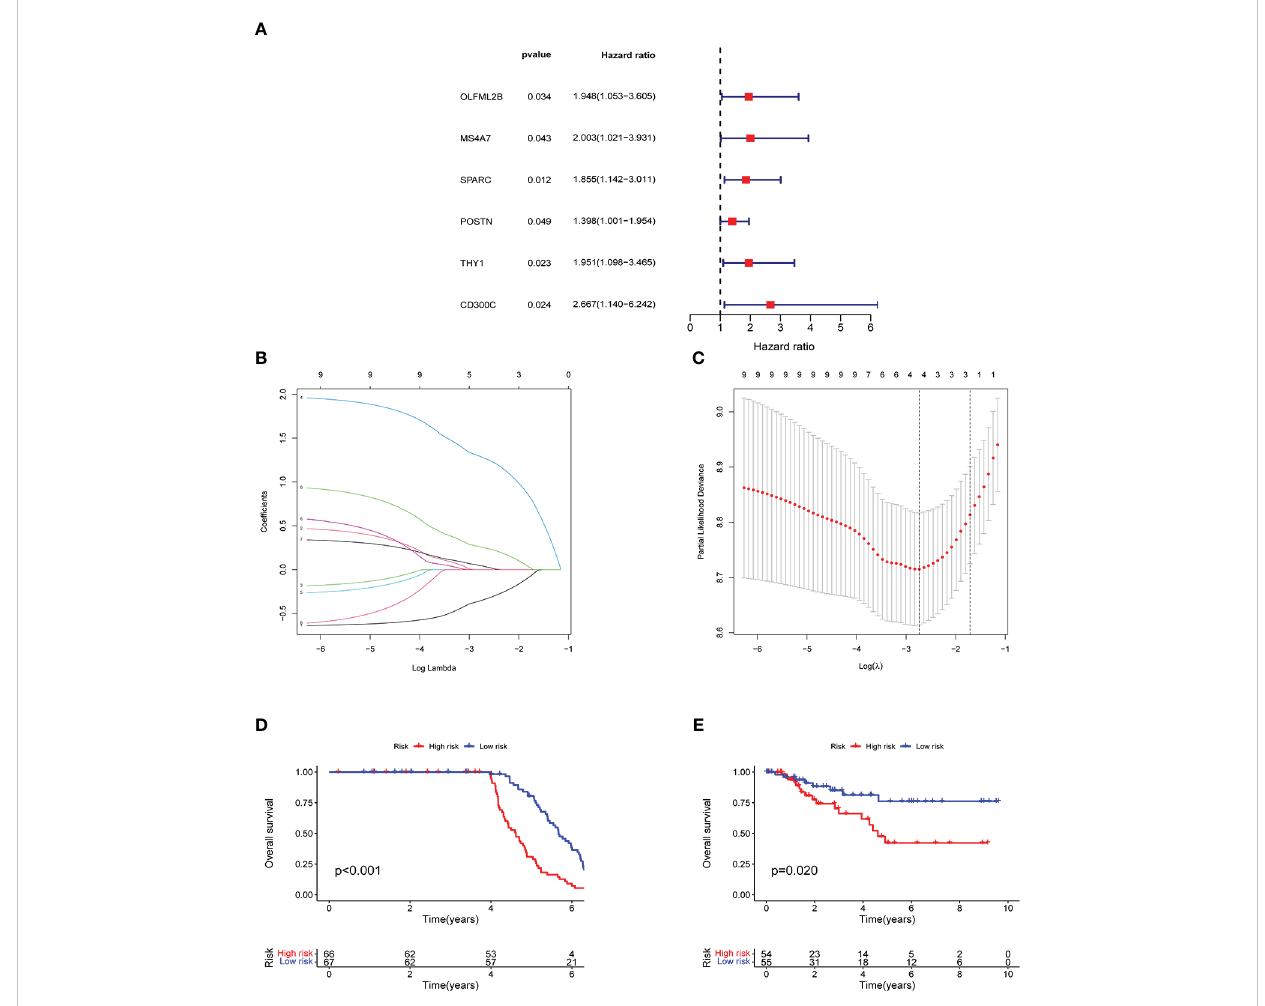
FIGURE 4 Model construction and veri fi cation results: A shows the results of univariate prognostic analysis, B shows the results of lasso regression analysis, C shows the results cross-validation, D shows the results of survival analysis in GEO, E shows the results of survival analysis in